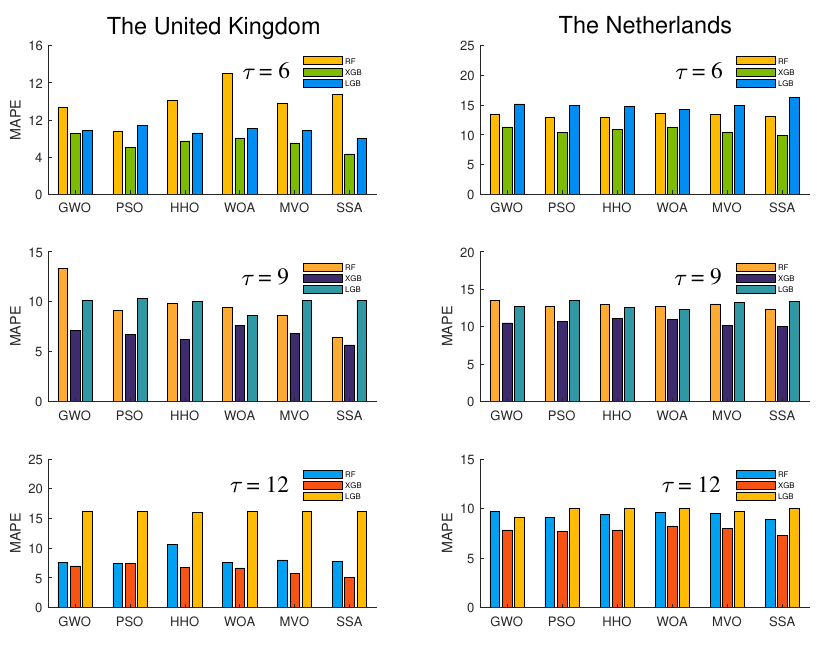
Figure 17. MAPE of models on different datasets.